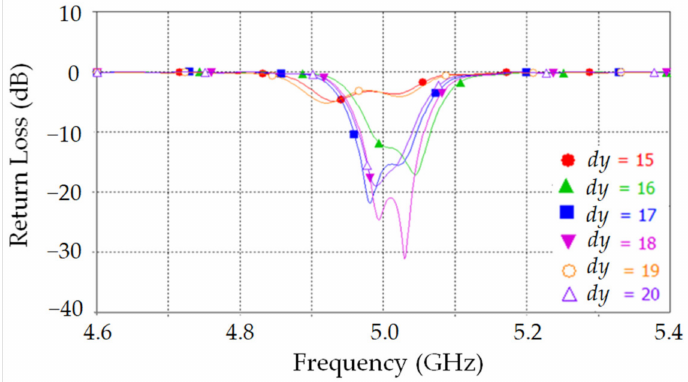
Figure 3. Simulated return loss for different values of ‘ d y